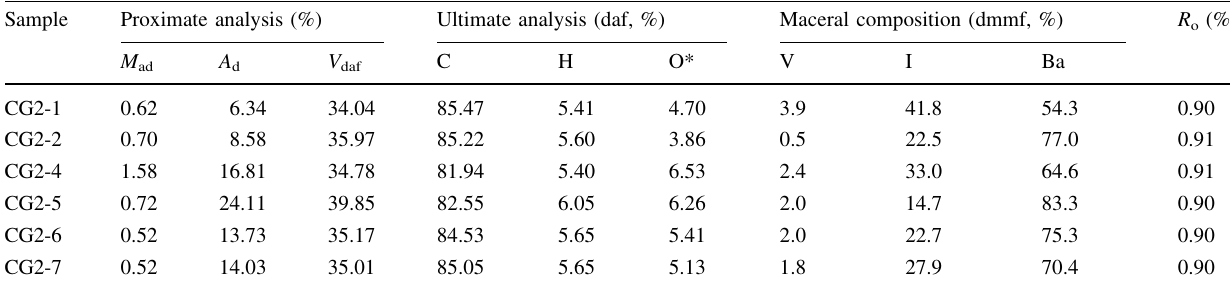
Table 1 Basic characteristics of samples